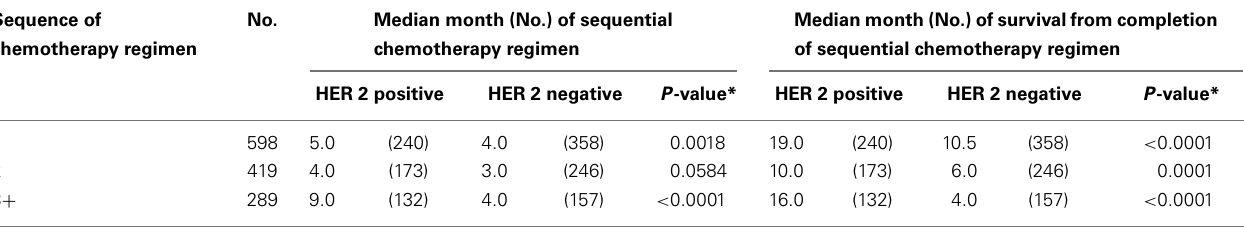
Table 4 | Median months of sequential chemotherapy regimen and survival from completion of sequential treatment, stratified by HER 2 status. Sequence of chemotherapy